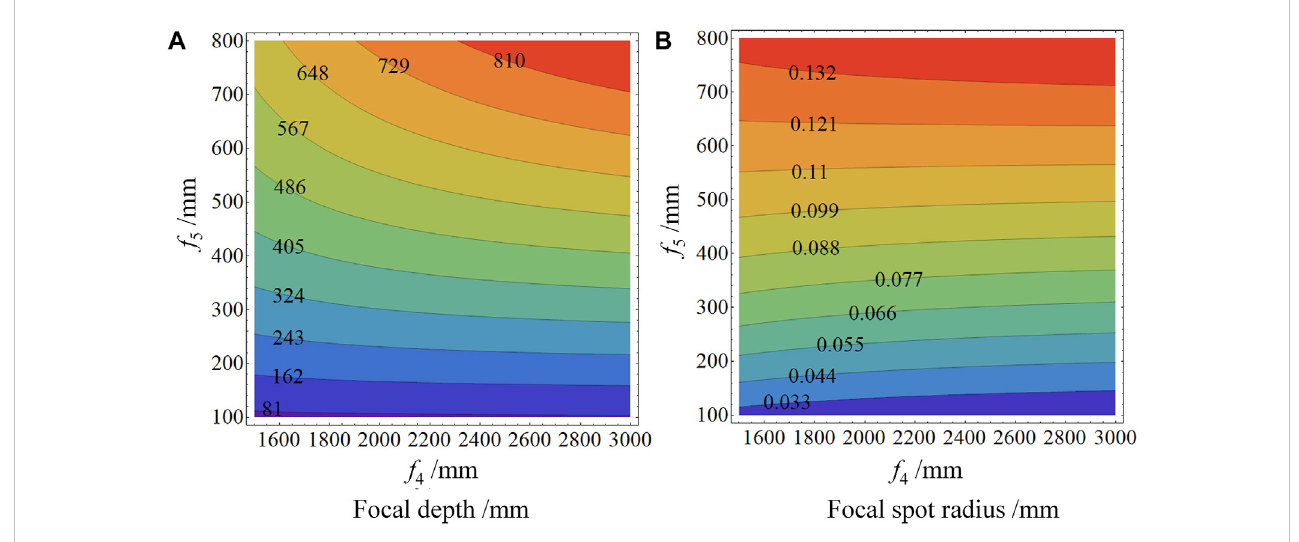
FIGURE 2 Contour map of beam parameters with respect to focal lengths of lens in setup